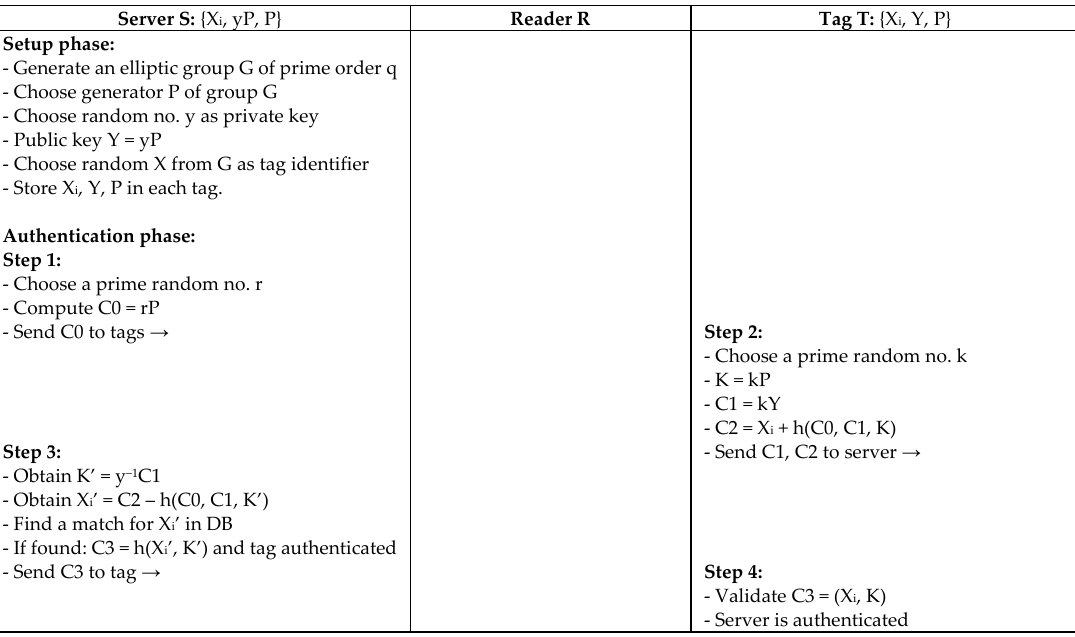
Figure 6. Mutual Authentication Protocol Based on Elliptic Curve Cryptography (IECC) by Farash.